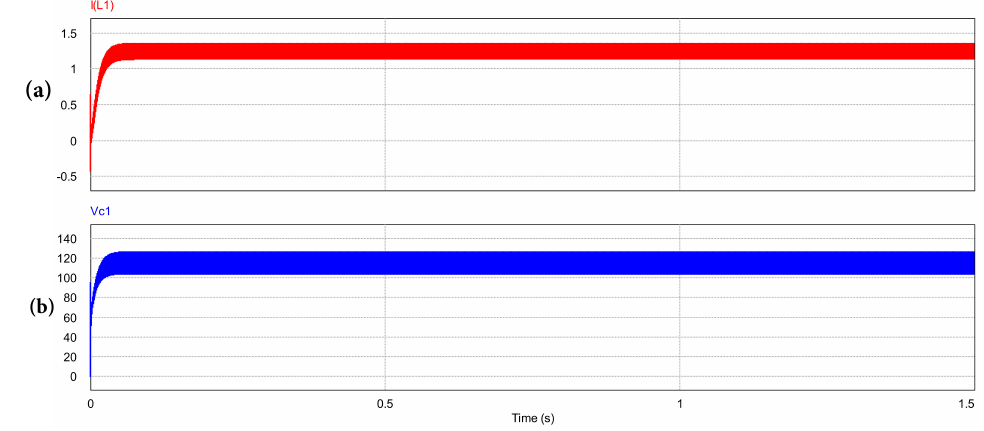
Figure 20. Cuk converter performing in closed loop. ( a ) inductor one current, ( b ) capacitor one voltage.